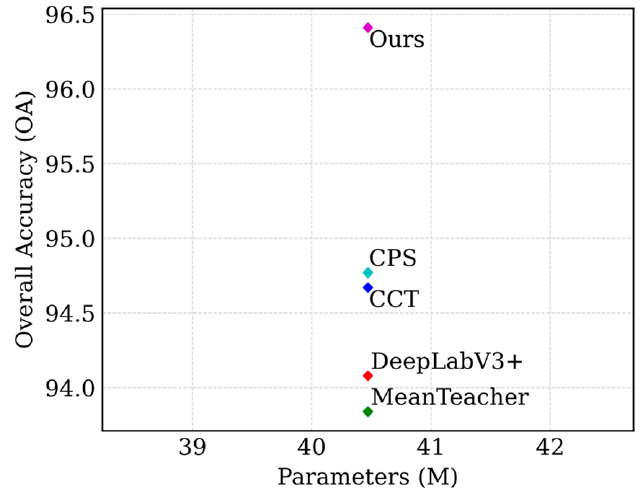
Figure 7. Models’ performance versus the number of parameters.